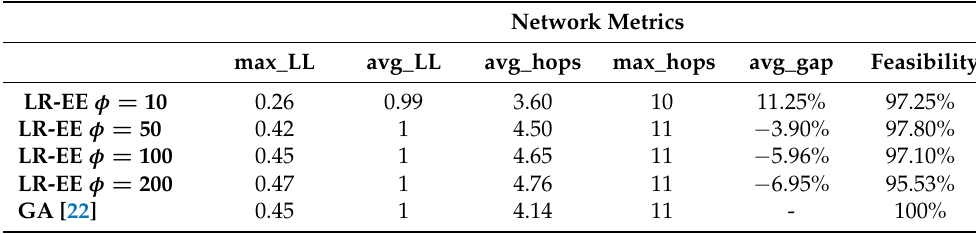
Table 2. Network metrics for LR-EE and